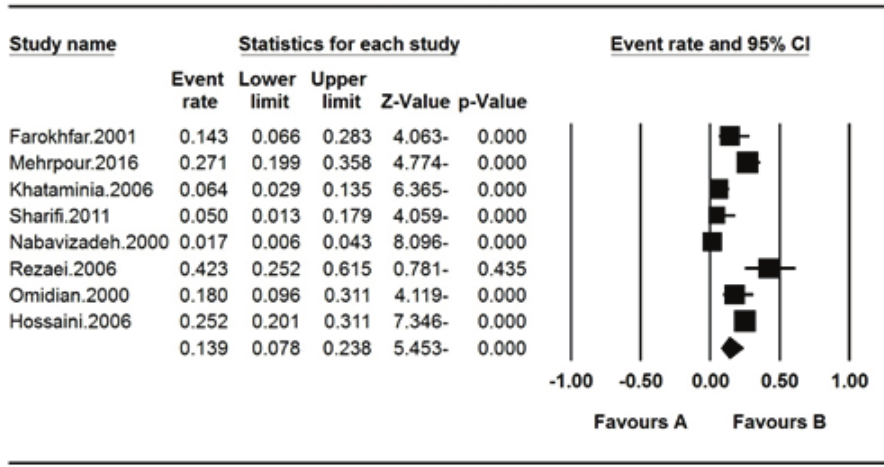
Figure 6. The prevalence of red color blindness (Protan) in Iranian